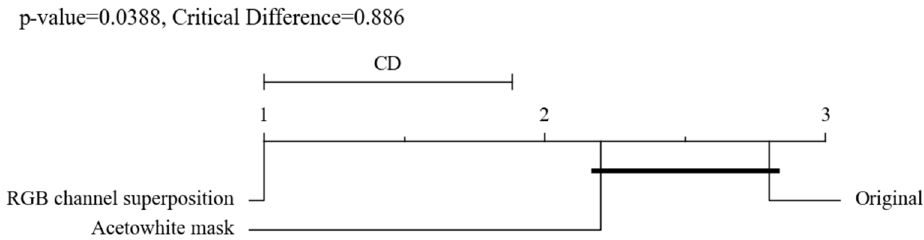
Figure 4. Critical Difference Diagram of the Friedman–Nemenyi test for deep learning model performance comparison. The number shows the lank of three models. The lower the rank, the better the performance of a model.